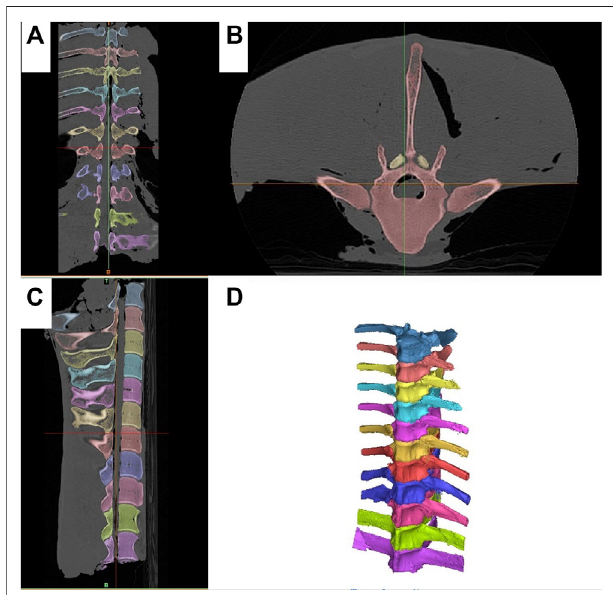
FIGURE2| Segmentation oftheT11-L1spinesegments.Eachvertebra is segmented separately and denoted in a different color. (A) Dorsal CT scan